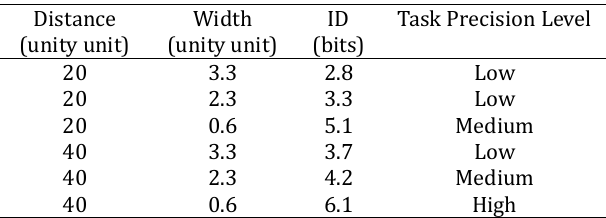
Table 2. ID and task precision